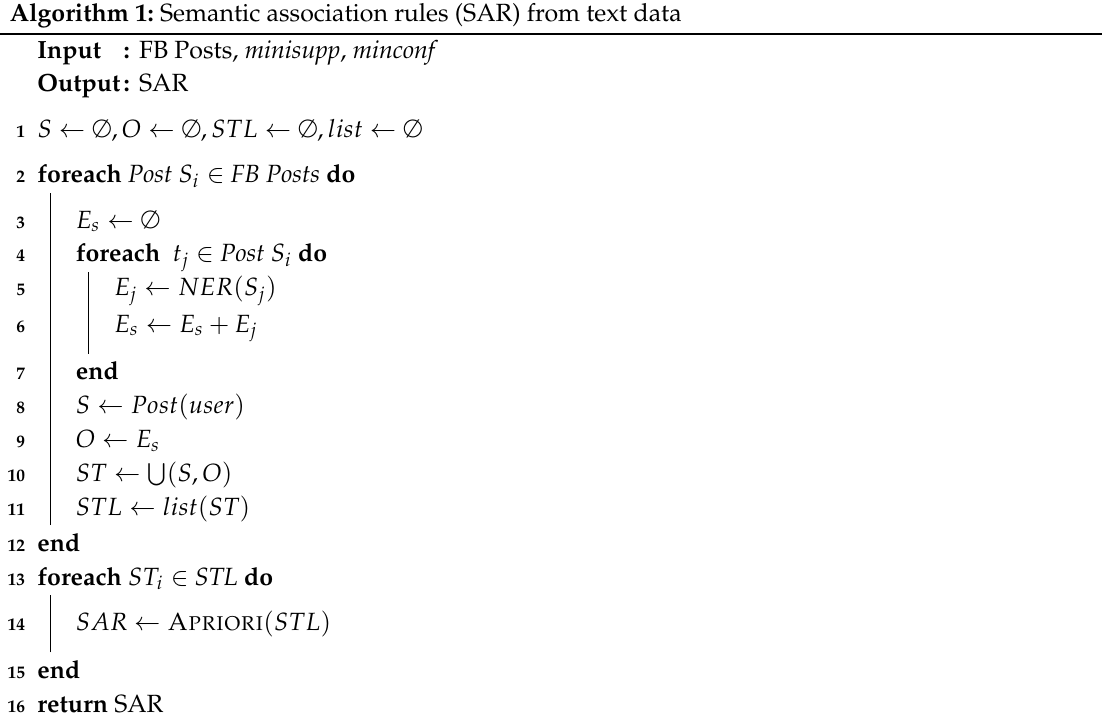
Figure 4. Structure of myPersonality dataset. Algorithm 1: Semantic association rules (SAR) from text